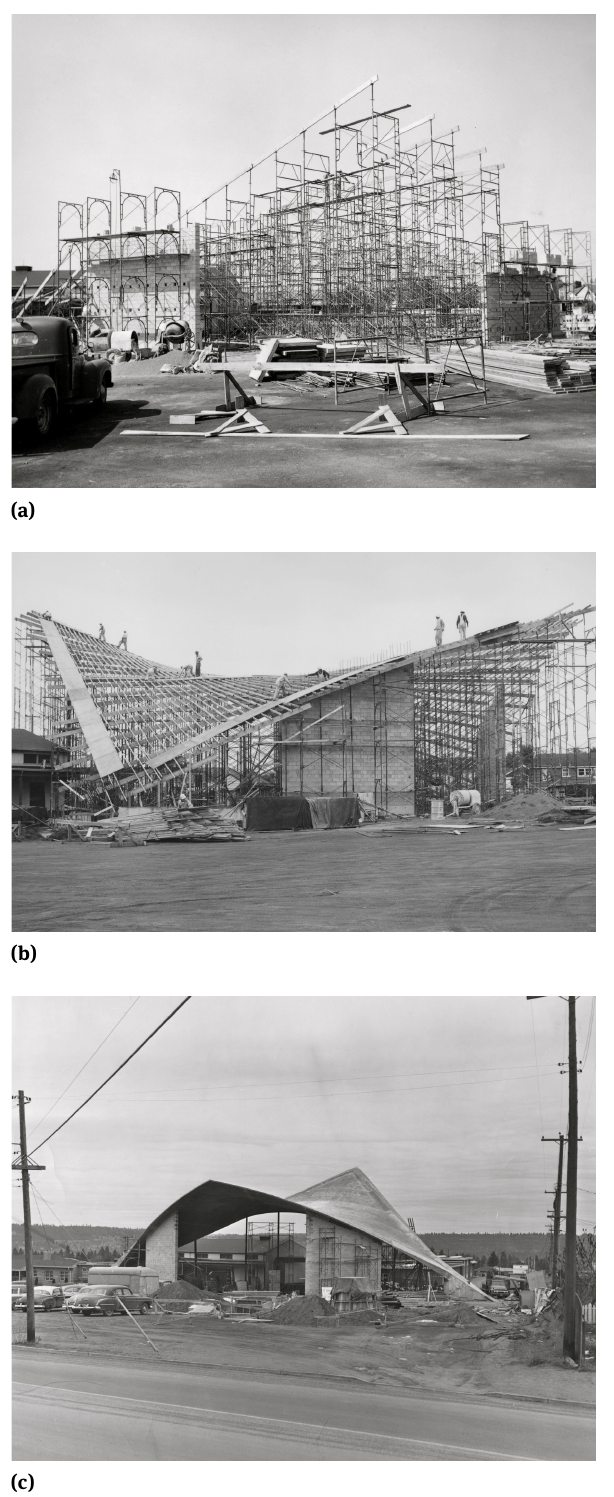
Figure 8: a) Scaffolding b) Formwork and c) Concrete shell